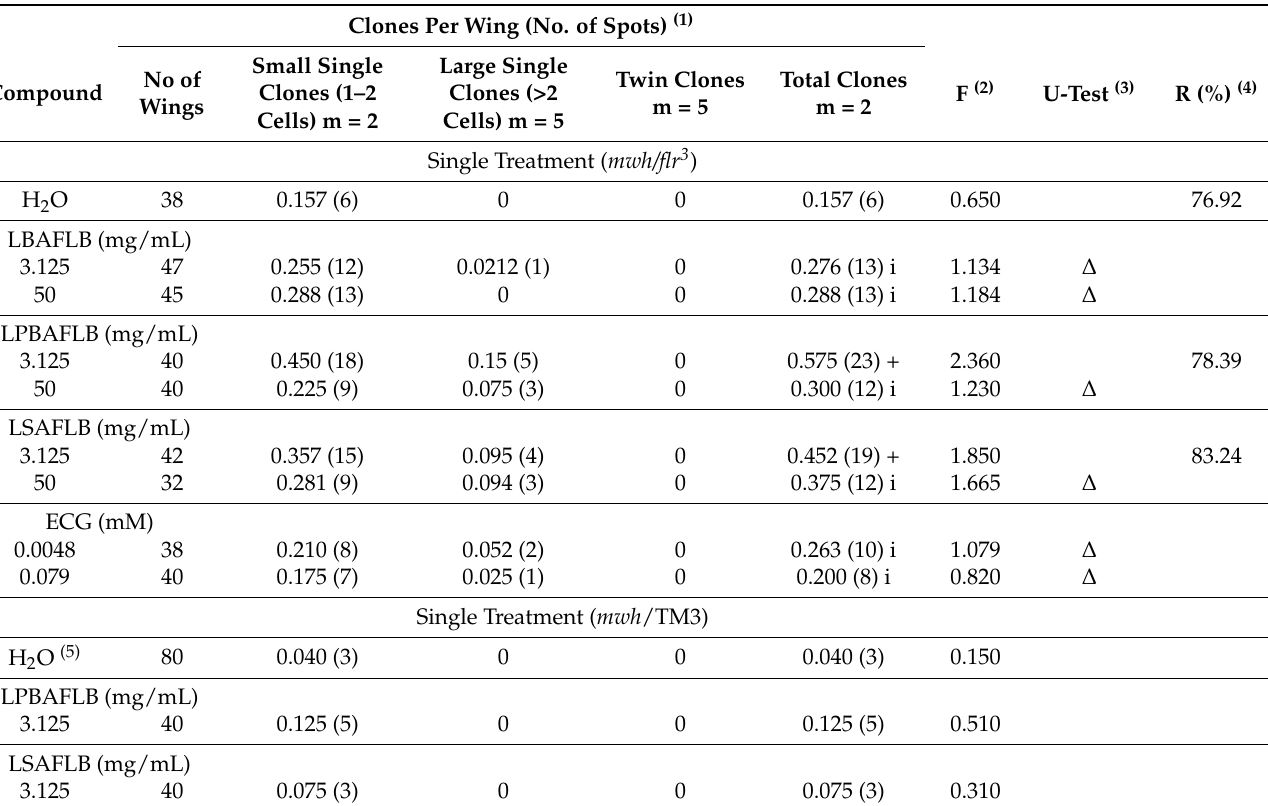
Table 2. Genotoxicity of lyophilised blond alcohol-free lager beer (LBAFLB), lyophilised pale-blond alcohol-free lager beer (LPBAFLB), lyophilised stout alcohol-free lager beer (LSAFLB) and epicatechin gallate (ECG) in the Drosophila wing spot test. Clones Per Wing (No. of Spots)